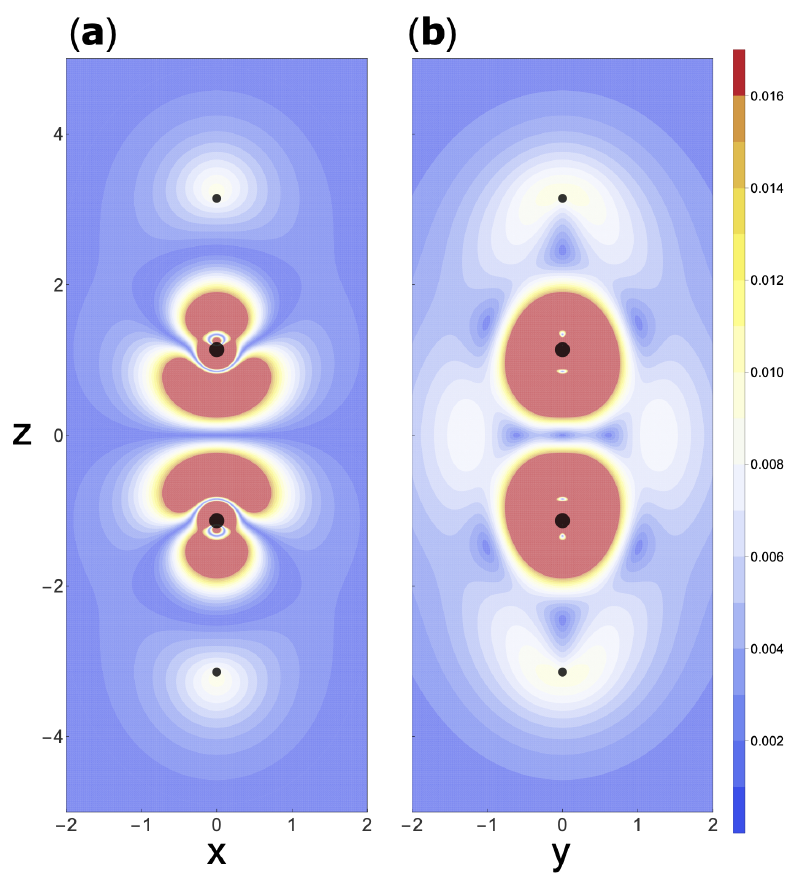
Figure 6. Contour plots of the norm of the current density | j | in the ( a ) xz plane ( left ) and ( b ) yz plane ( right ) of the C 2 H 2 molecule at its equilibrium geometry with a magnetic field of 0.10 B 0 along the x -axis.